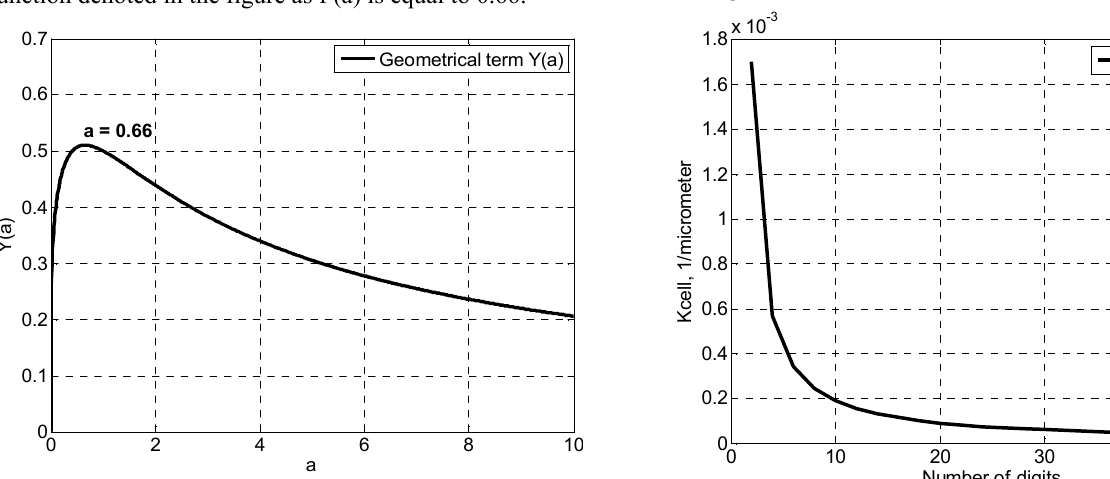
Fig. 5: The geometrical cell constant K Cell by varying the number N of electrodes in the optimization case W = S ⋅ 3/2. The finger length L is 1000 μ